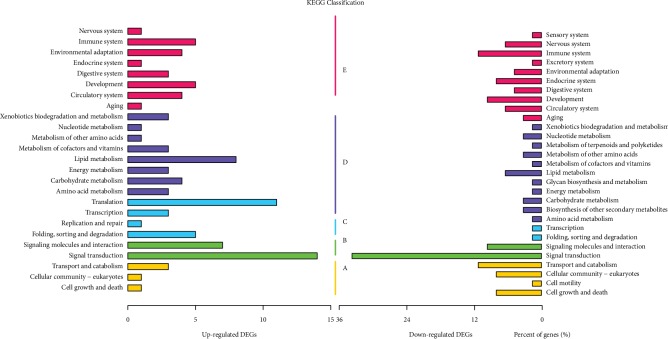
KEGG classification analysis of upregulated and downregulated DEGs. (a) Cellular processes. (b) Environmental information processing. (c) Genetic information processing. (d) Metabolism. (e) Organismal systems.